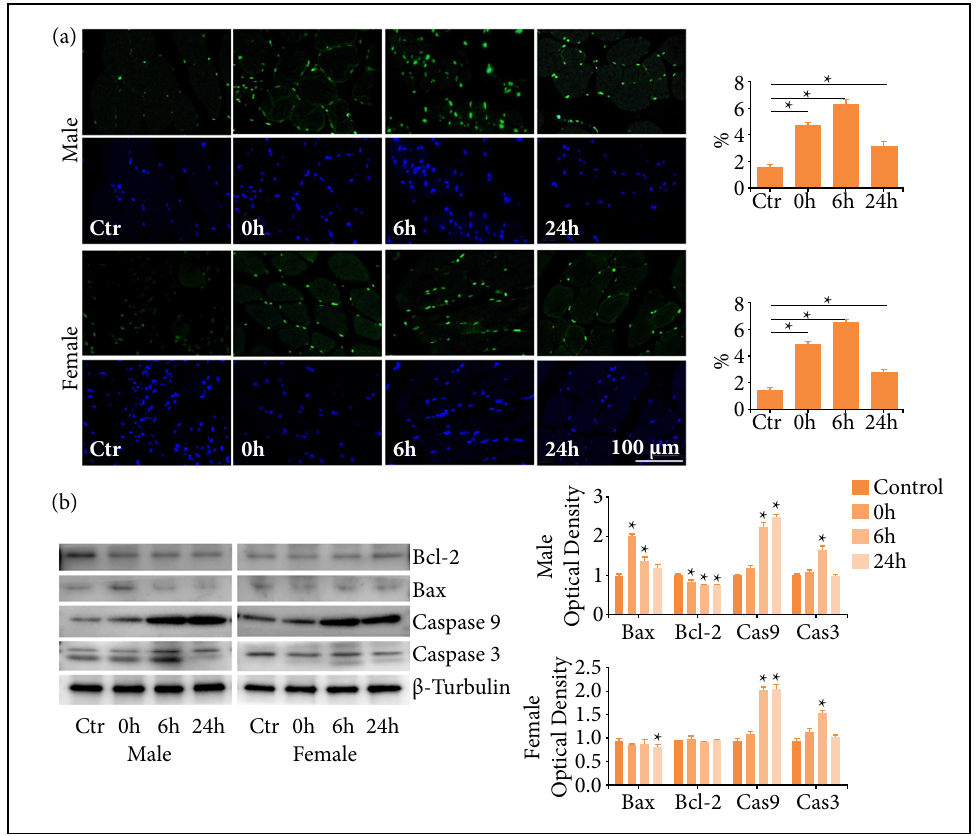
Figure 2 - One-time high-load exercise induce apoptosis of muscle; (a) Apoptosis detected by TUNEL staining; (b) Expression of apoptosis-related protein detected by Western blot. * p < 0.05 compared with the control